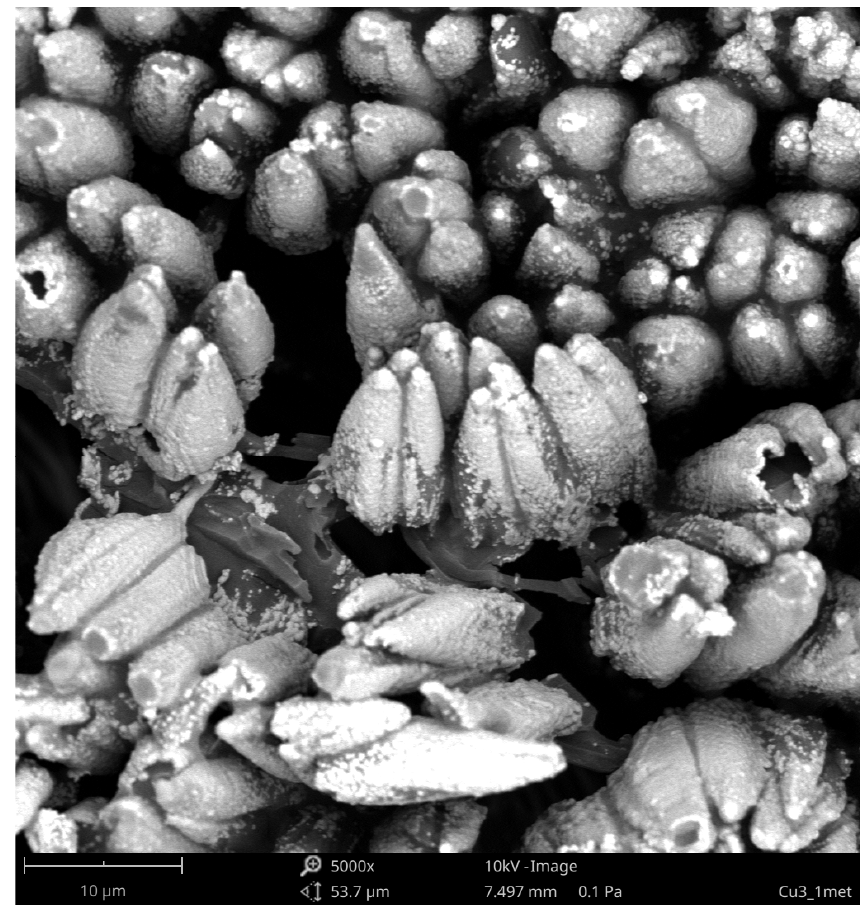
Figure 6. SEM image of metallized B3 coating (N = 300).